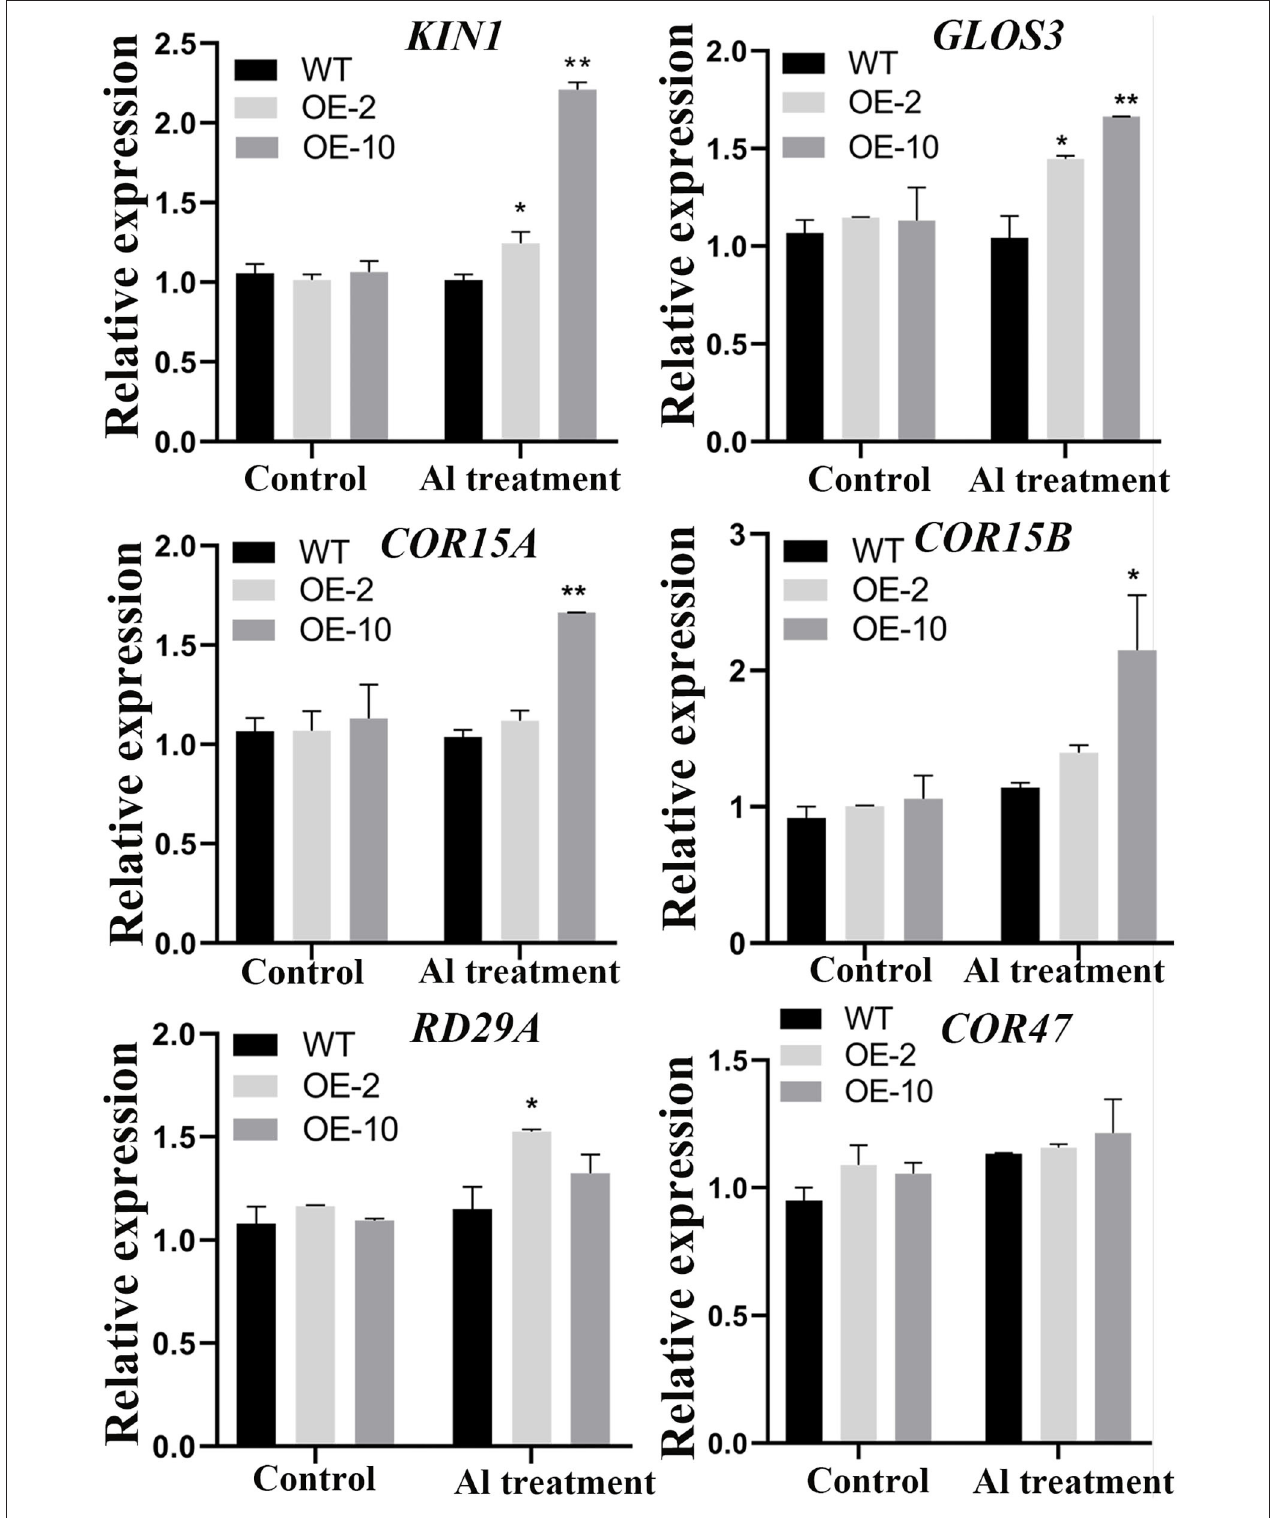
FIGURE 7 | Expression patterns of stress-responsive genes regulated by GmWRKY21 in Arabidopsis. WT, wild-type Arabidopsis; OE-2, OE-10: GmWRKY21 overexpression transgenic lines. WT and transgenic Arabidopsis were grown on 0 or 100 µ M AlCl 3 (pH 4.3) 1/2MS medium for about 10 days. All data are presented as means ± SEM ( n = 3). Significant differences according to the one-way analysis of variance are denoted as follows: ** P < 0.01 and * P < 0.05.